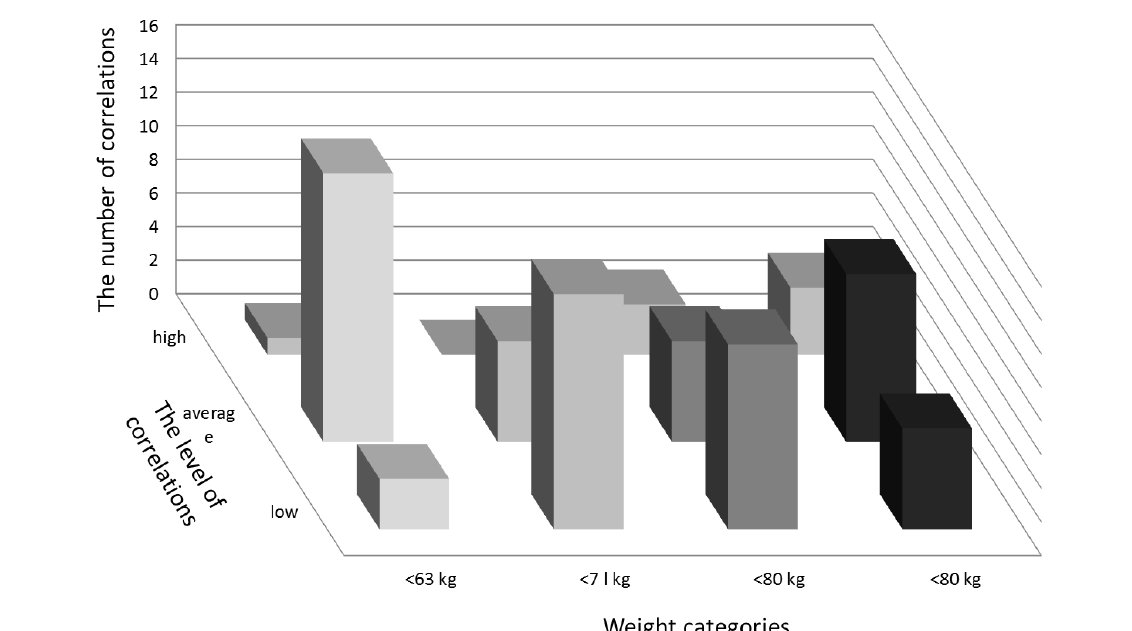
Fig. 1. The structure of correlations between somatic characteristics and the sports level among highly qualified taekwon-do ITF athletes.